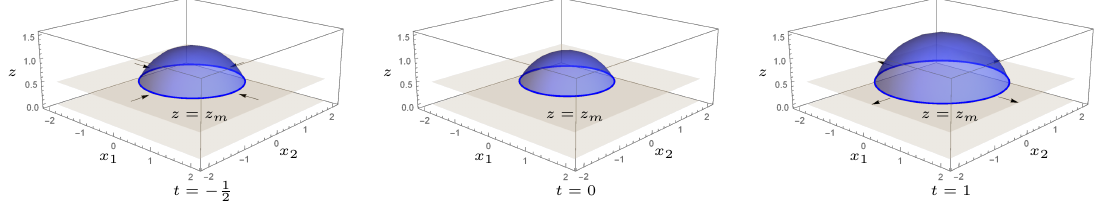
Figure 3 . Snapshots of the (Lorentzian) membrane solution (3.4) as it contracts and expands in time. For the sake of the plots, we have only shown the case of a (2 + 1) -dimensional membrane (i.e., with p = 2 ), but the solution is valid for arbitrary p . The p = 1 case reduces to a string worldsheet, as depicted in figure 2